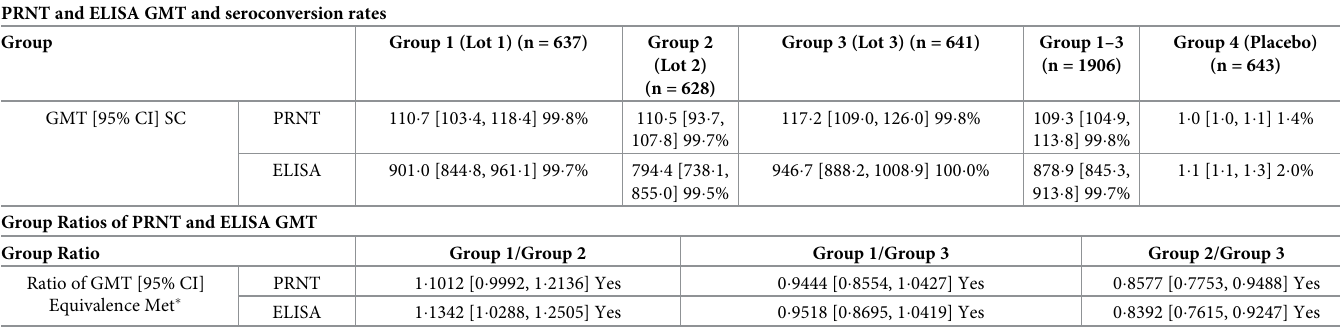
Table 4. PRNT and ELISA GMTs, seroconversion rates and GMT group ratios 2 weeks after the second vaccination (PPS, n = 2549). PRNT and ELISA GMT and seroconversion rates Group